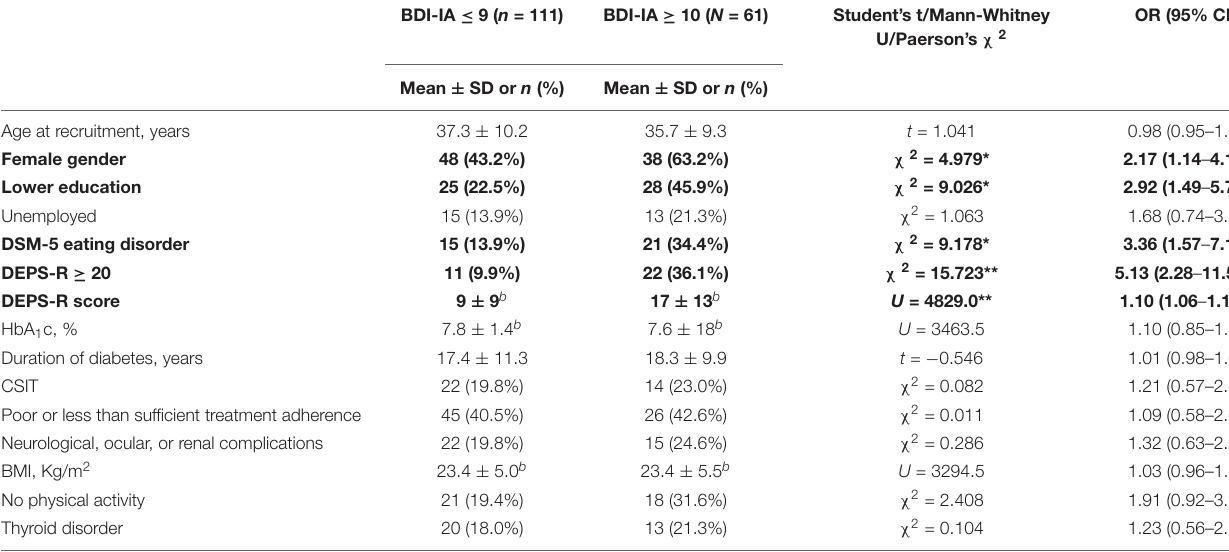
TABLE 7 | Association between predictors and depression in univariate